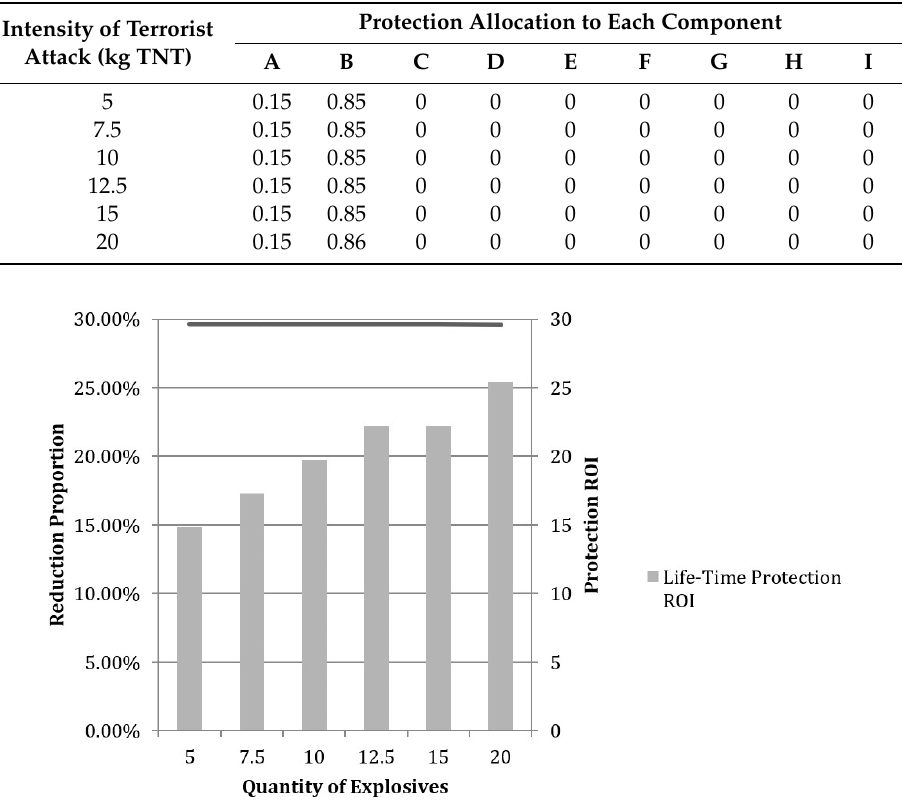
ff ectiveness of Protection at Varied Attack Figure 4. Effectiveness of Protection at Varied Attack Levels. Figure 4. E